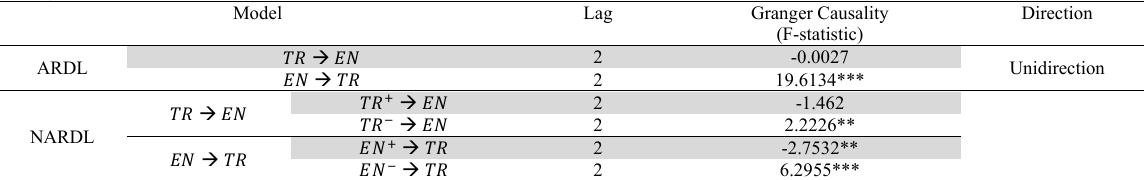
Granger causality